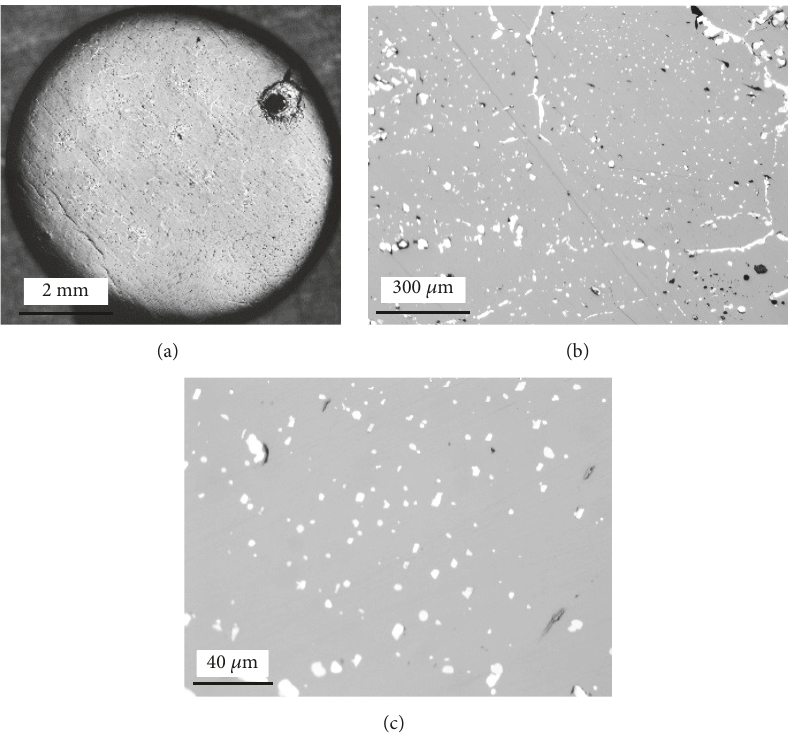
Figure 5: Macro- ( 1 ) and microstructure (b, c) of the corium.